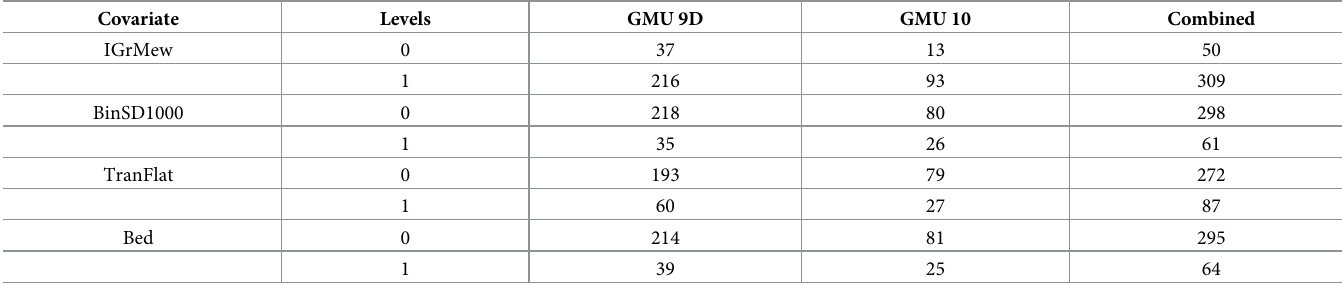
Table 1. Sample sizes for categorical covariates used in the mark-resight distance models by Game Management Unit, Southwest Alaska. Covariate Levels GMU 9D GMU 10 Combined IGrMew 0 37 216 309 BinSD1000 218 298 TranFlat 193 79 272 27 87 Bed 0 214 81 295 39 25 64 GMU 9D –denotes Game Management Unit 9D, Alaska Department of Fish and Game, and is at the southern end of the Alaska Peninsula. GMU 10 –denotes Game Management Unit 10, Unimak Island only, which is the eastern most Aleutian Island and only island in the archipelago inhabited by brown